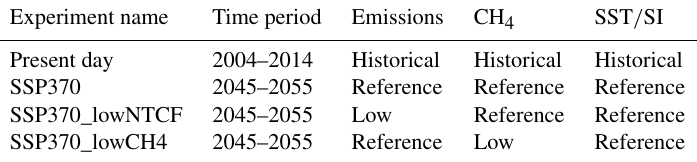
Table 1. Model configurations for present-day and future simulations. “Emissions” refers to emissions of O 3 precursors and aerosols. “CH 4 ” refers to prescribed surface CH 4 mixing ratios. “SST / SI” refers to prescribed sea surface temperature and sea ice concentrations. “Historical” means that the emissions, CH 4 mixing ratios or SST / SI evolve as for the CMIP6 historical simulations, and “Reference” means that they evolve as for SSP3-7.0. “Low” emissions or CH 4 mixing ratios evolve following SSP3-7.0 but with lower emissions or CH 4 mixing ratios.